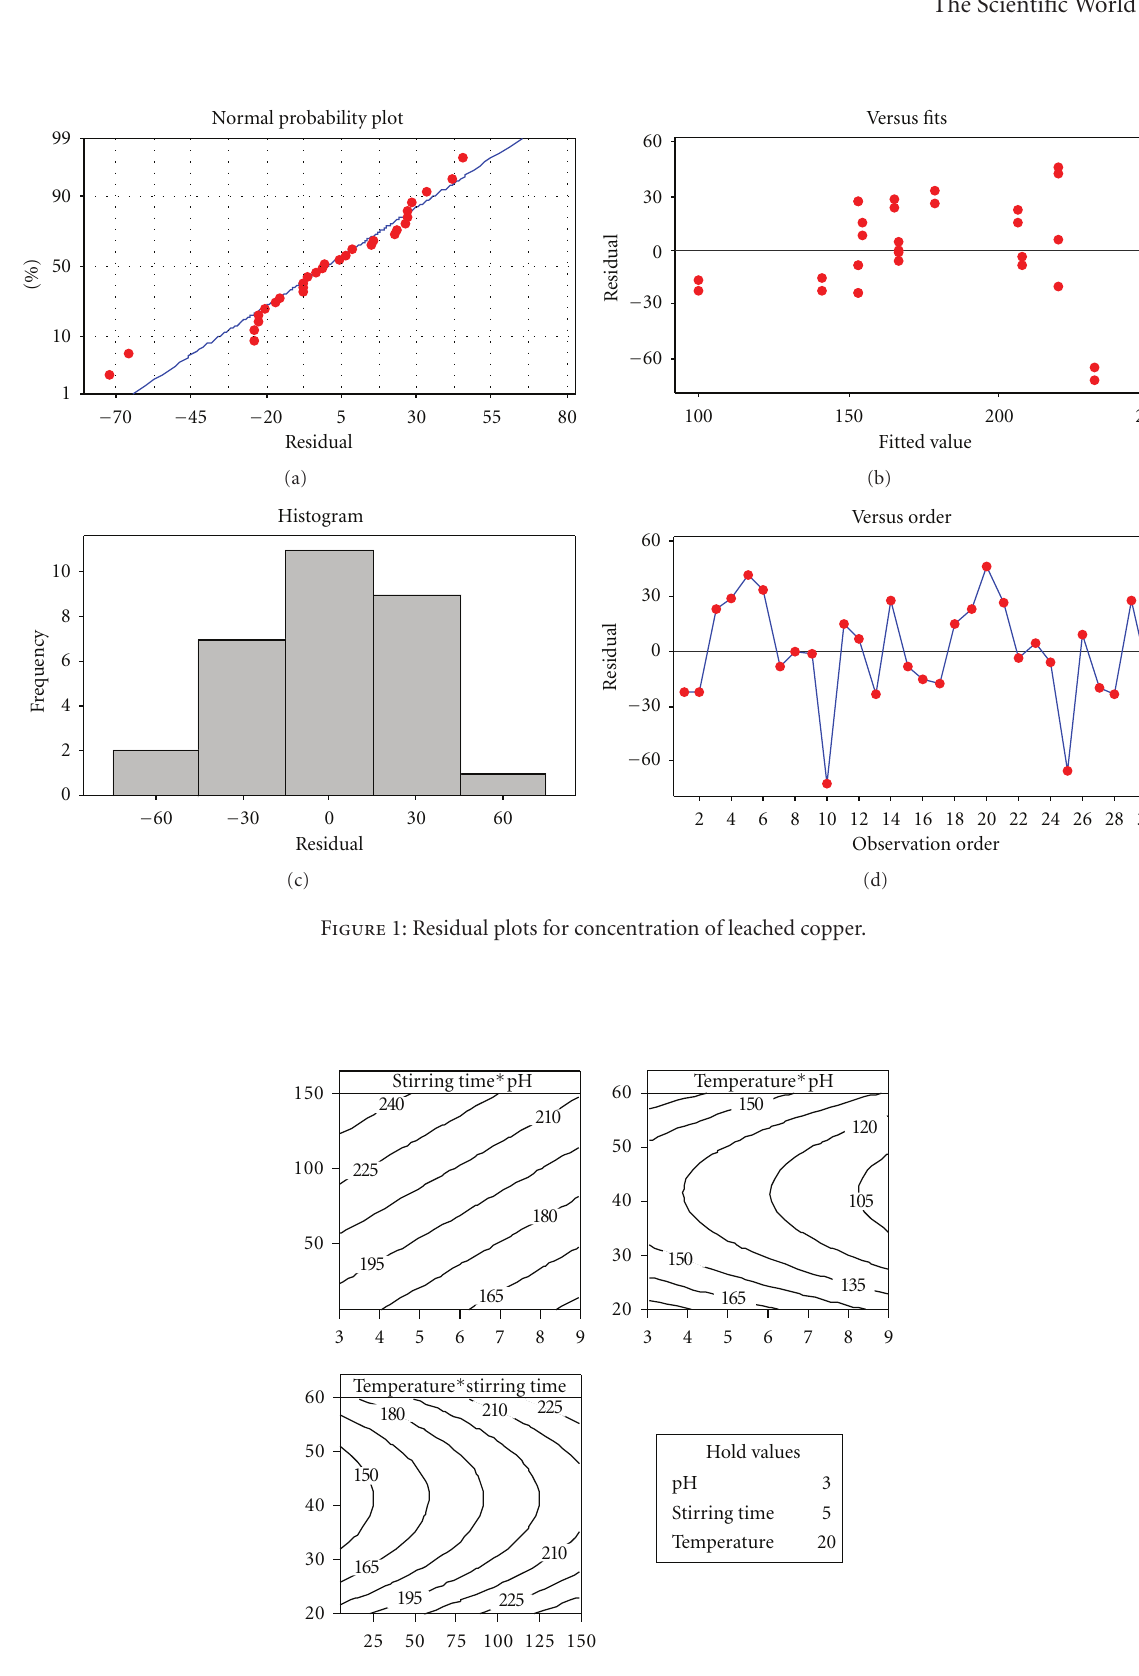
Figure 2: Contour plots of concentration of leached